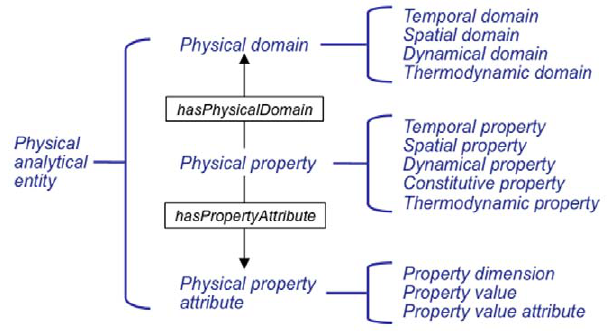
Figure 1. OPB main classes. The top-most OPB class is OPB: Physical analytical entity (at the right) which has, following a suggestion by Maxwell [31], subclasses OPB: Physical domain , OPB: Physical property , and OPB: Physical property attribute (center) with subclasses of each shown at the left. Each OPB: Physical property class is assigned to one or more OPB: Physical domain classes (by a hasPhysicalDomain relation; gray arrow) and to one or more OPB: Physical property attribute classes (by hasPropertyAttribute